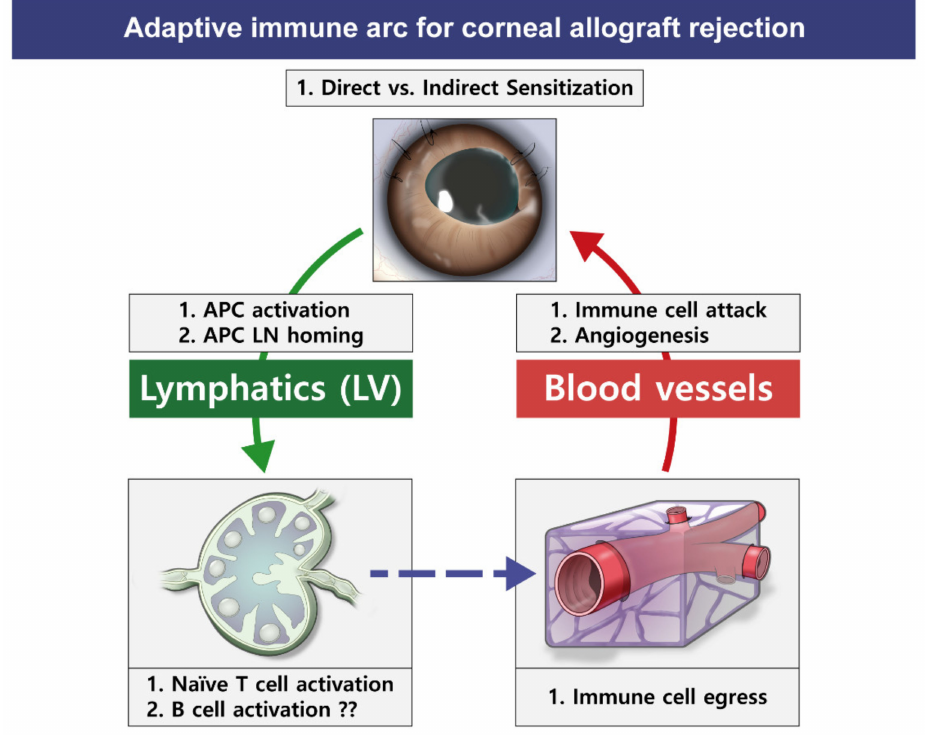
Figure 4. Adaptive immune arc for corneal allograft rejection. Antigen presenting cells (APCs) from donor corneal button (direct sensitization) or recipient bed (indirect sensitization) leave and migrate through lymphatic vessels into draining lymph nodes (LN). The T cells activated from the interaction between APCs and naive T cells then egress into peripheral blood and immune attack the donor